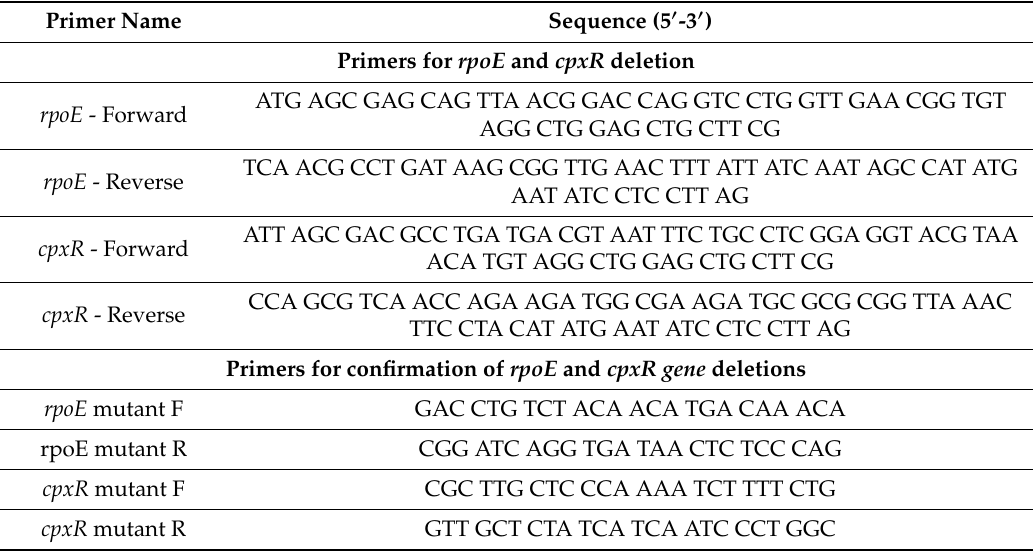
Table 1. Primers used for construction of